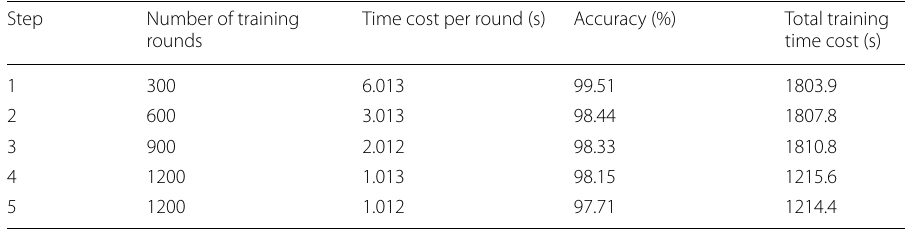
Table 3 Training time cost and detection accuracy with different window sliding steps Step Number of training